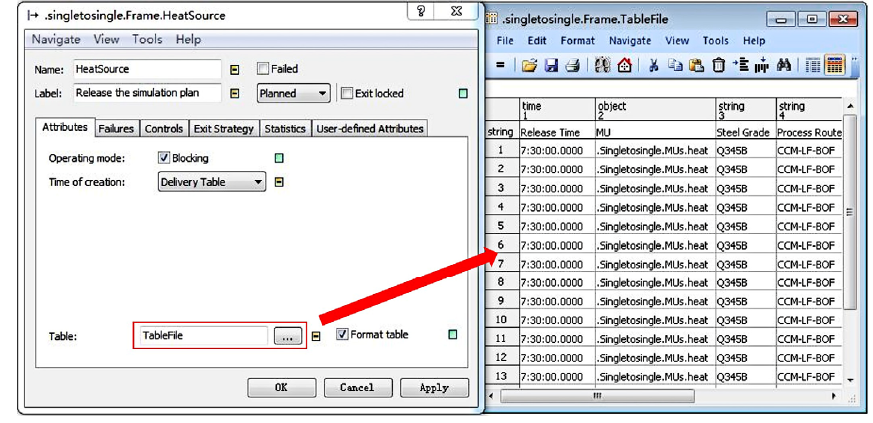
Figure 2. Presentation of simulation instance.